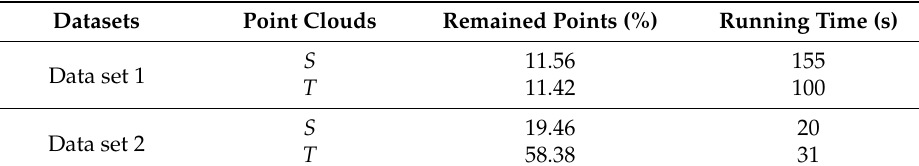
Table 4. The results of selection of matching points without normal space sampling.